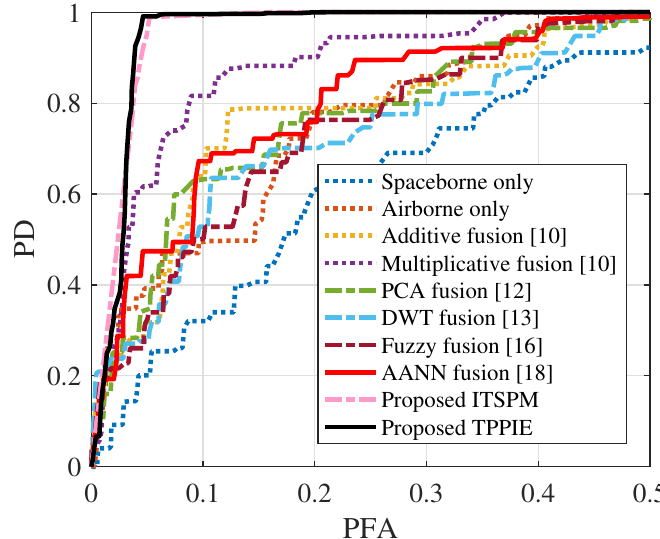
Figure 13. ROC curves of different methods for Experimental Scene 2. When pursuing a relatively high PD (e.g., larger than 0.98), the PFAs of the proposed ITSPM and TPPIE fusion methods were far less than those of the other methods, including spaceborne image processing, airborne image processing, additive fusion [10], multiplicative fusion [10], PCA fusion [12], DWT fusion [13], fuzzy fusion, and AANN fusion